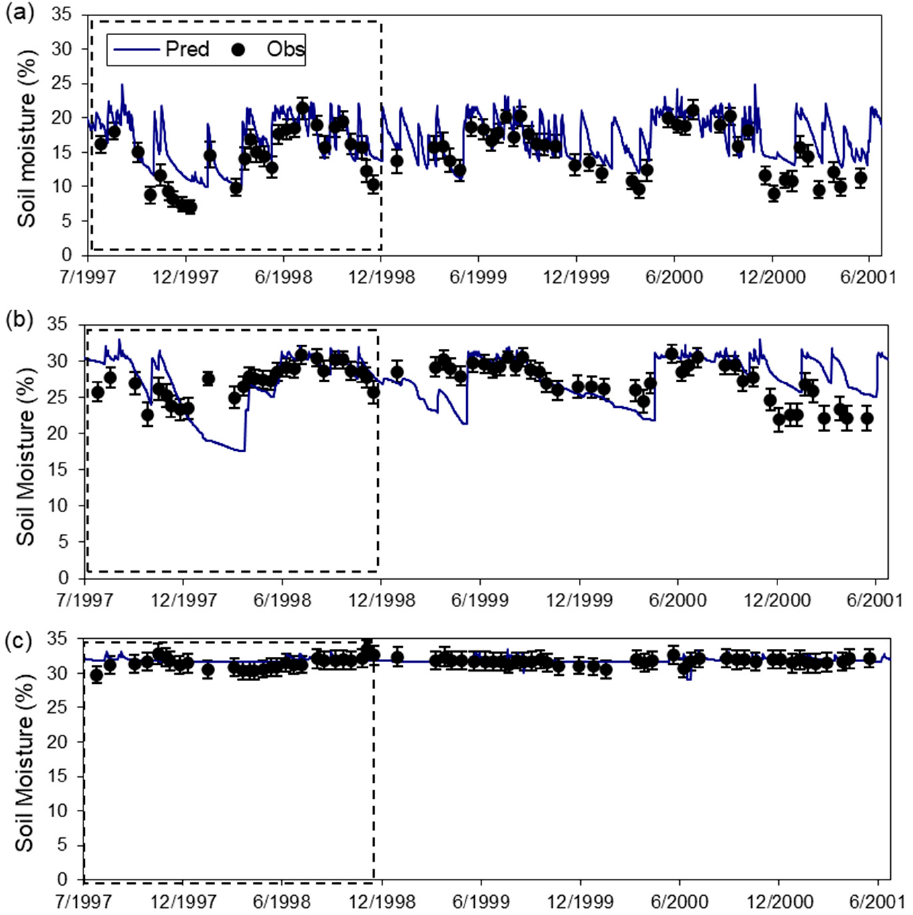
Figure 3. Predicted and observed soil volumetric moisture content (%) for ( a ) 20 cm ( b ) 40 cm and ( c ) 140 cm depths for the RM system (the segmented box indicates the period for the parameter value setting). Note: Points indicate the mean of the observed data; whiskers indicate the standard error of the mean.